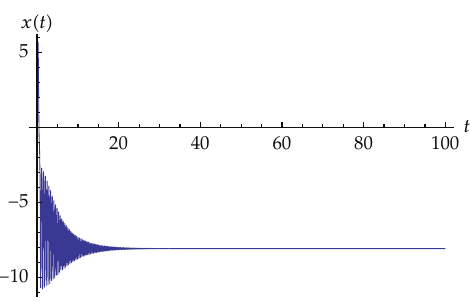
Figure 9: Controlled signal α (cid:8) 0 . 99 (cid:3) k (cid:8) 20 (cid:4) .